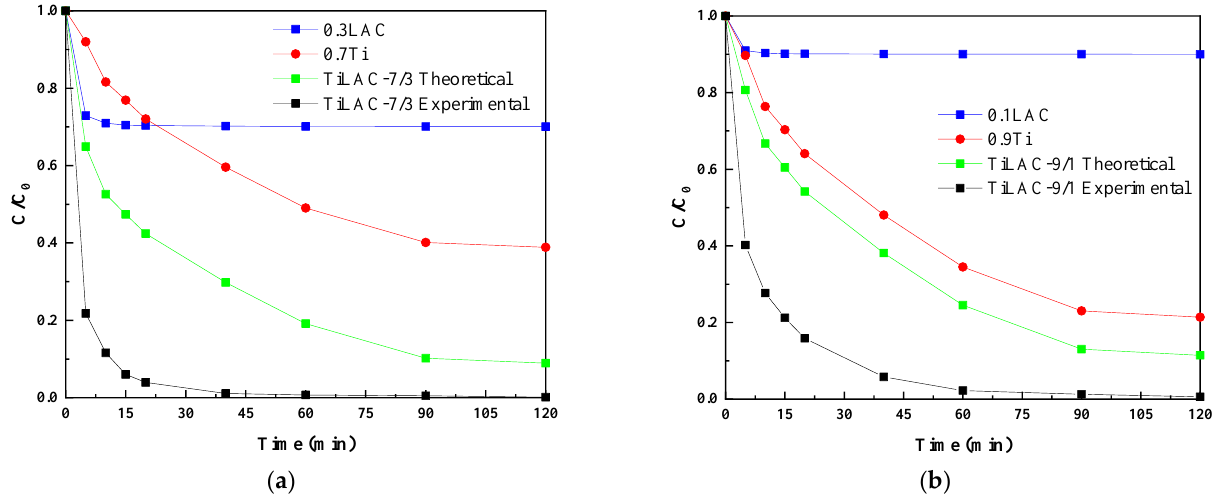
Figure 8. Comparison of the experimental MB removal for ( a ) TiLAC-7/3 and; ( b ) TiLAC-9/1 with that predicted according to their individual components and contents.